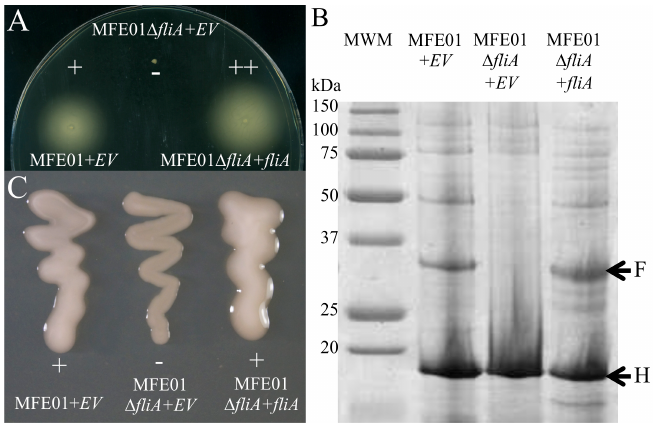
Figure 3. E ff ect of fliA mutation on phenotypes of MFE01. ( A ) Swimming motility. Swimming assays were performed on 0.3% LB-agar for 24 h at 28 ◦ C. + : motile, − : non-motile, ++ : hyper-motile. EV: empty pPSV35. The images shown are representative of three assays ( n = 3). ( B ) Hcp and flagellin secretion. Concentrated supernatants of cultures in the late exponential growth phase, grown at 28 ◦ C, were analysed by SDS-PAGE (12% separation gel) and Coomassie staining. Bands indicated by the arrows and labelled H and F were identified by MALDI / ToF as Hcp and flagellin proteins, respectively. The periplasmic alkaline phosphatase of MFE01, used as control for cell lysis, was not detected in these experiments. MWM: molecular weight marker, EV: empty pPSV35 vector. ( C ) Mucoid phenotypes. Mucoidy was assessed on 1.5% LB-agar, supplemented with 50 µ g / mL gentamycin, after incubation for 24 h at 28 ◦ C. EV: empty pPSV35 vector, + : mucoid, − : non-mucoid. The images shown